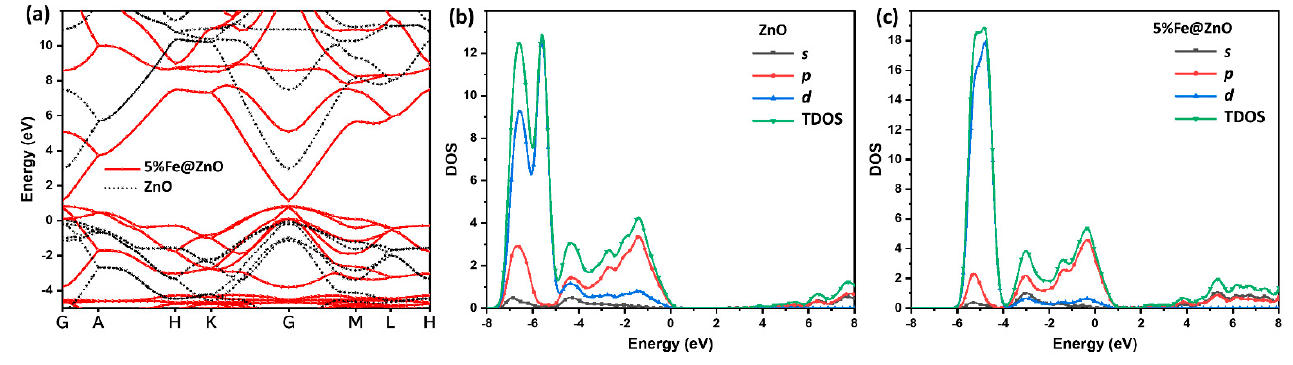
Figure 5. Calculated band structure of wurtzite ZnO and 5%Fe doped ZnO ( a ); Total and partial density of state of ZnO without Fe ( b ); and with 5% Fe ( c ). density of state of ZnO without Fe ( b ); and with 5% Fe ( c